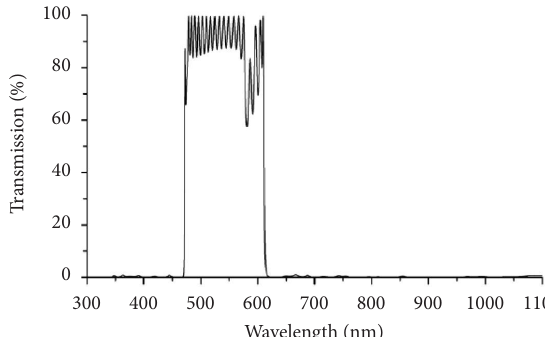
Figure 6: Transmission spectrum of the designed bandpass flter excluding the substrate refections [22].